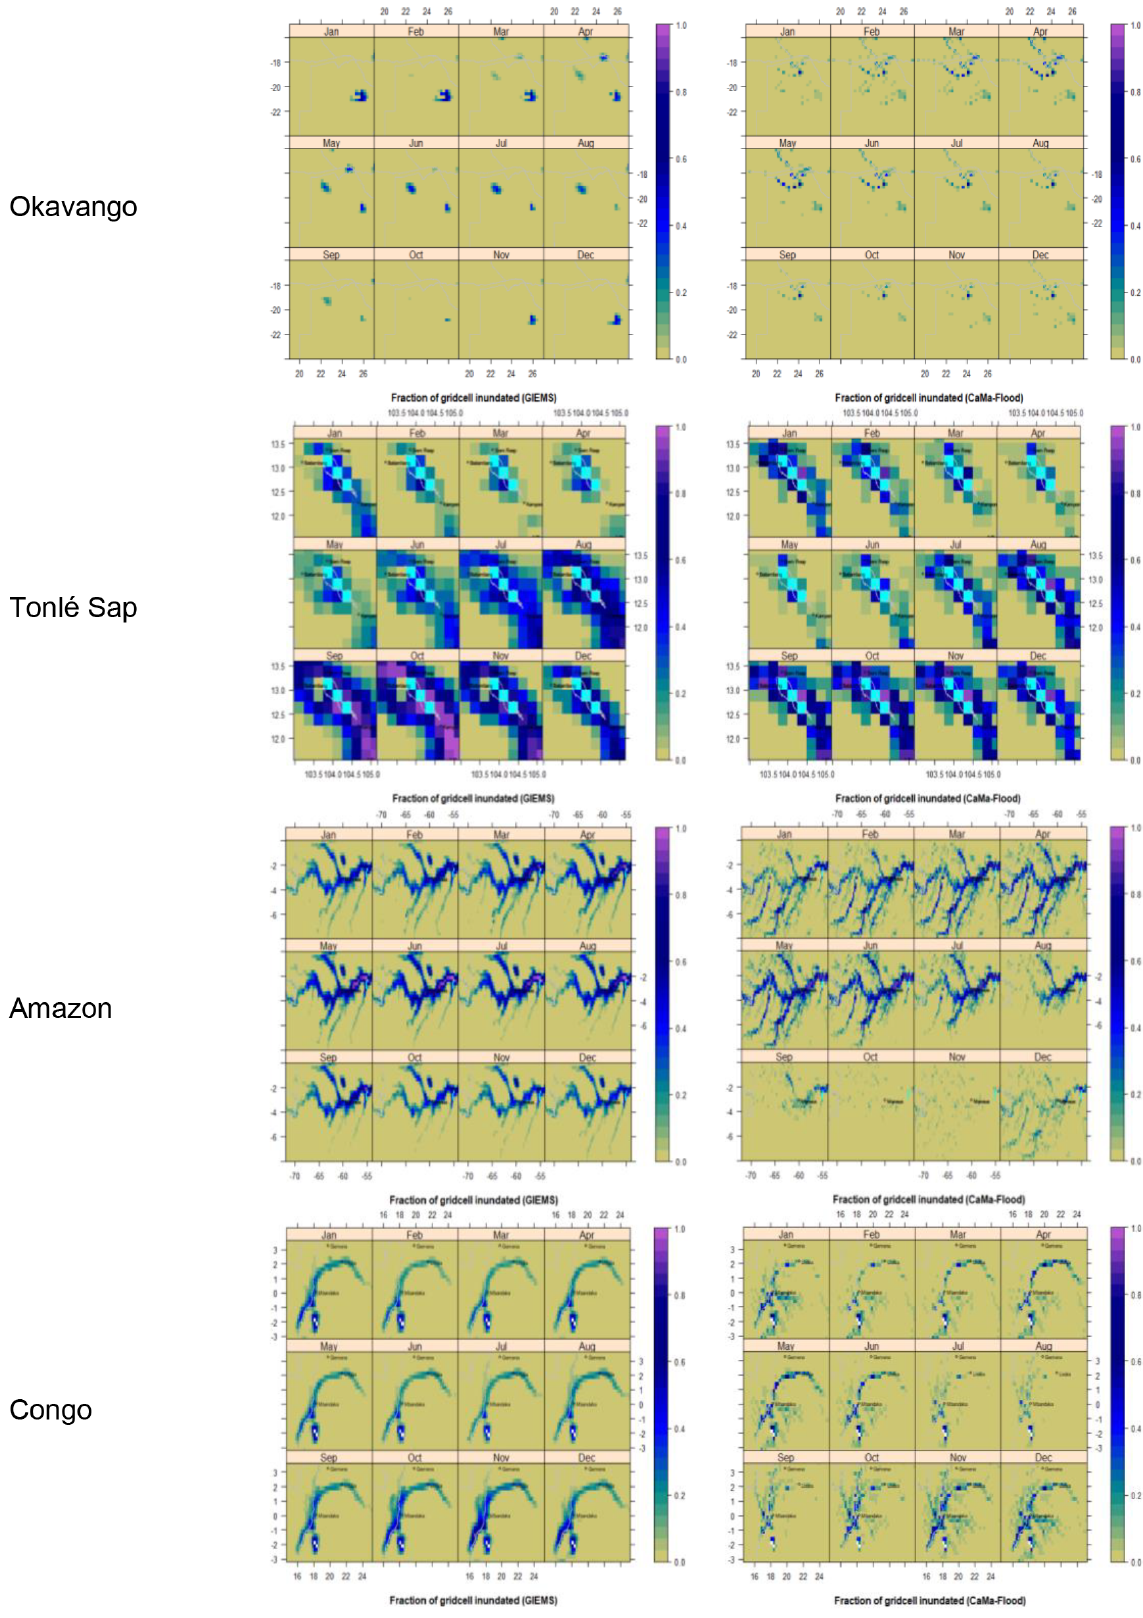
Figure 3. Hydrol. Earth Syst. Sci., 26, 3151–3175, 2022